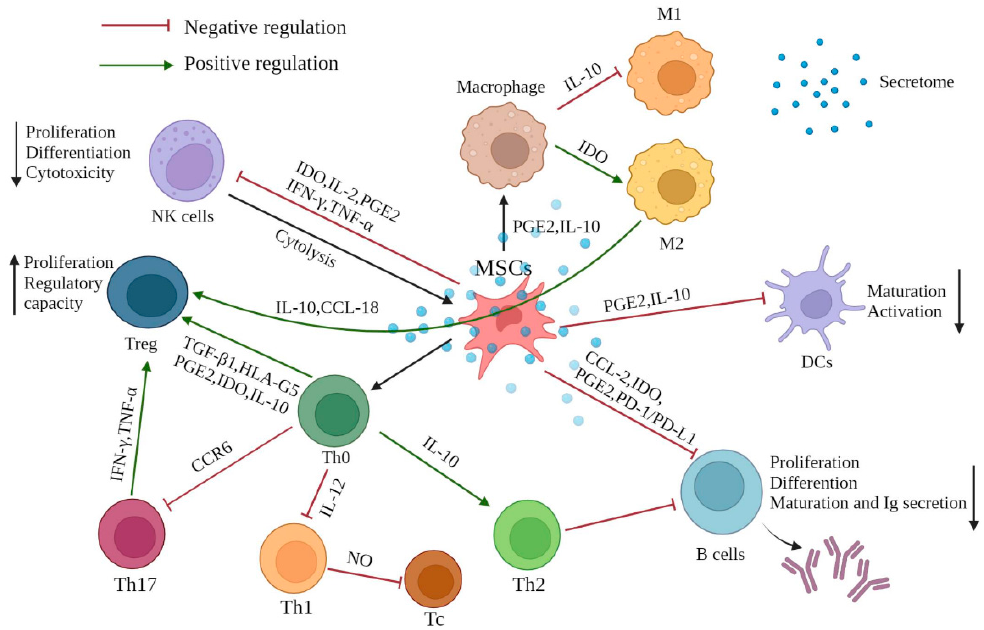
Figure 1. The effect of MSC-mediated immunomodulation on immune cells. MSCs exhibit immunomodulatory effects mainly through direct cell contact with innate and adaptive immune cells and the multifunctional secretome produced by the of paracrine mechanism of MSCs. MSCs mostly exert an immunosuppressive effect (red inhibitor), while performing positive regulation on generation of Treg cells, differentiation of Th2, and M2 macrophage polarization (green arrows). Various cytokines, chemokines, signaling molecules, and growth factors are involved in this mechanism, maintaining the immune homeostasis when the immune response is over-activated or under-activated. PGE2: prostaglandin E2; IDO: indoleamine-pyrrole 2,3-dioxygenase; IFN- γ : interferon- γ ; TNF- α : tumor necrosis factor- α ; TGF- β : transforming growth factor- β ; IL: interleukin, PD-1/PD-L1: pro-